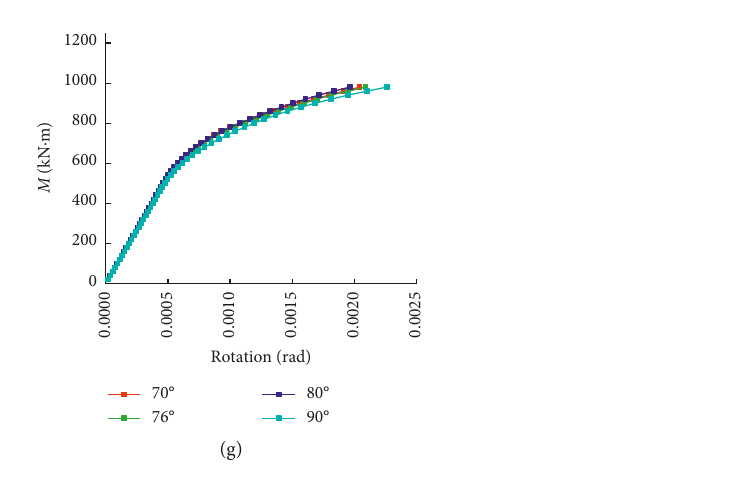
Figure 14: Bending moment-rotation curves for different tenon dip angles under axial loads of (a) 500 kN, (b) 1000kN, (c) 1500kN, (d) 2000kN, (e) 2500kN, (f) 3000kN, and (g)